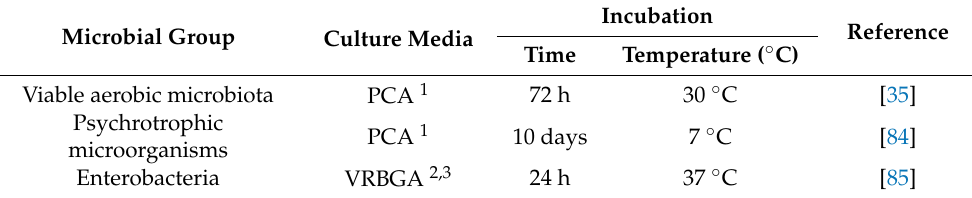
Table 4. Culture media, incubation conditions, and references for each microbial group studied. Microbial Group